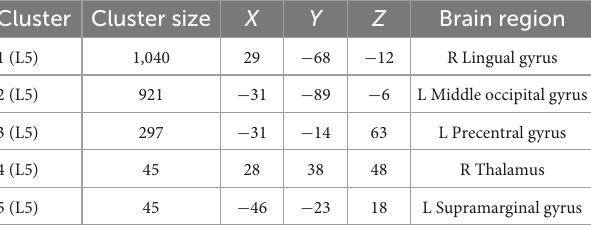
TABLE 1 Brain regions with significant differences between high and low load during the encoding period. Cluster Cluster size